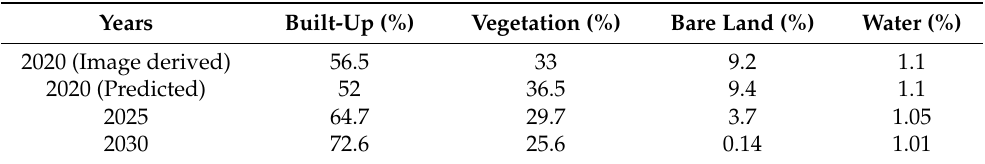
Table 5. Validation of percent change in LULC (by comparing predicted results for 2020 with the image derived results for the same year) and prediction for the year 2025 and 2030. Years Built-Up (%) Vegetation (%)